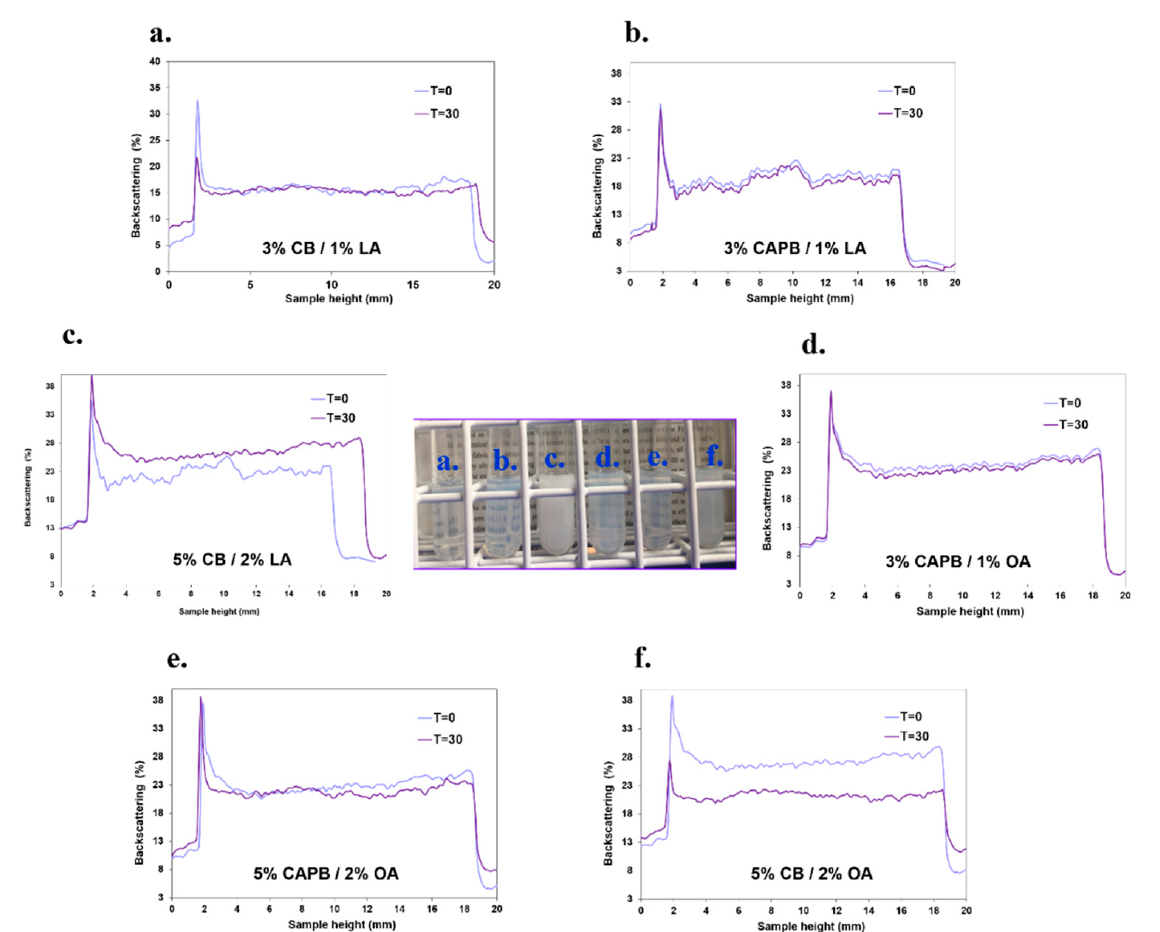
Figure 4. Backscattered profiles (BS) along the nanoemulsion as a function of the sample height (mm), analyzed for freshly prepared formulations (T = 0) and those stored for 30 days. The image presents the studied NE: sample 1 ( a ), sample 4 ( b ), sample 3 ( c ), sample 10 ( d ), sample 12 ( e ), sample 9 ( f ).